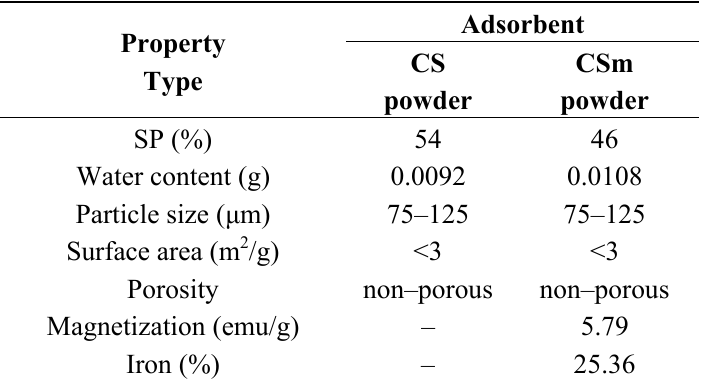
Table 1. Properties of the